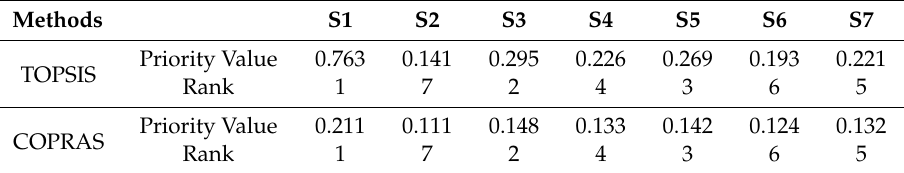
Table 6. Priority value and rank of systems determined using Technique for Order Preference by Similarity to an Ideal Solution (TOPSIS) and Complex Proportional Assessment